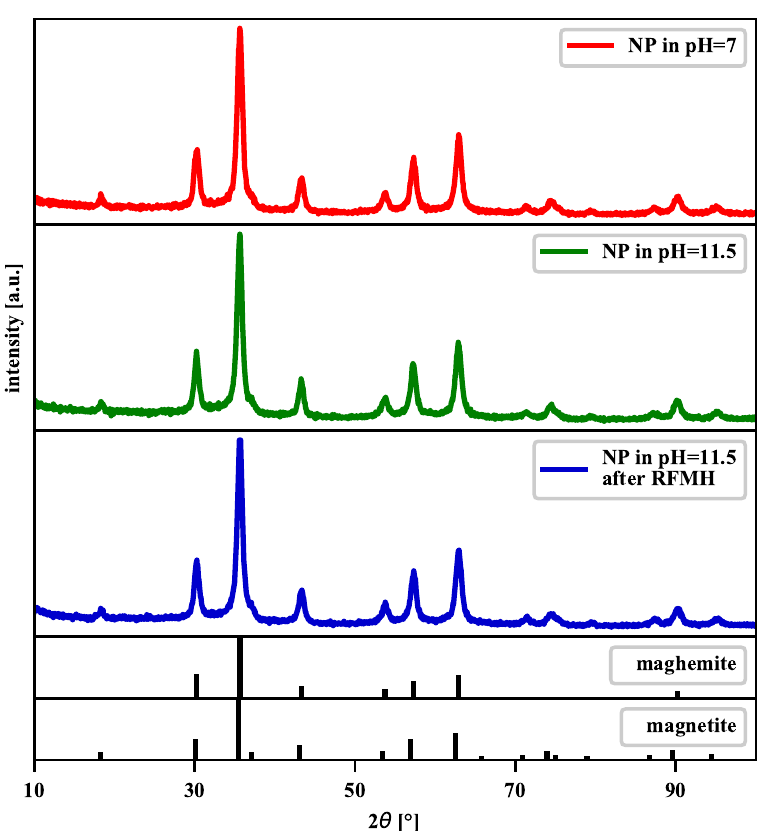
Figure 2. Wide-angle XRD patterns of the bare nanoparticles (NPs), NPs from the solution at the pH = 11.5 and NPs from the solution at the pH = 11.5 subjected to the 1800-s RFMH. The X-ray diffractograms of the maghemite and magnetite powders are presented in the two narrow panels at the figure bottom